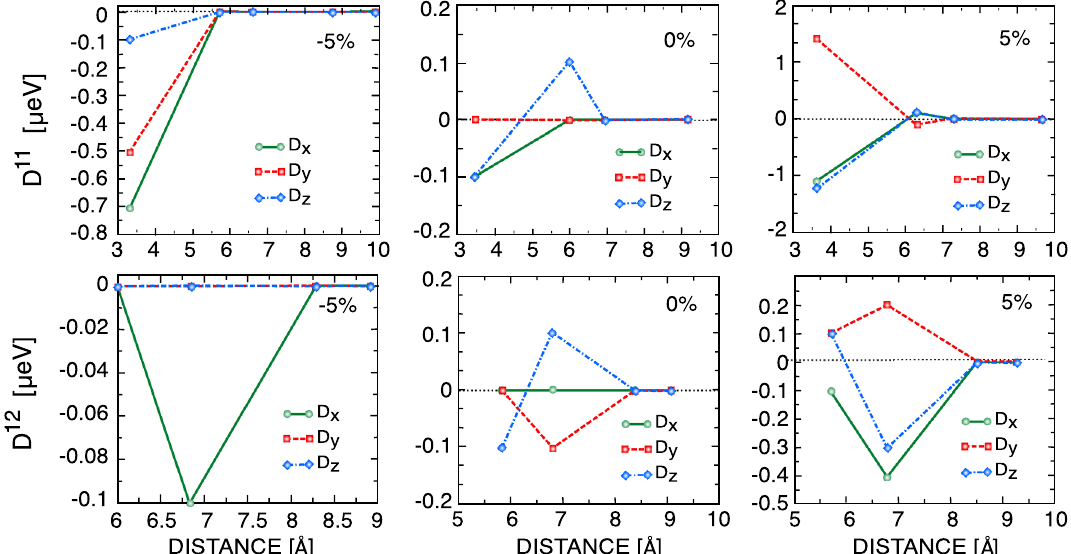
Figure 6. (Color online) Intralayer (top panel) and interlayer (bottom panel) DMIs of bilayer CrCl 3 for unstrained (middle), − 5% strained (left) and +5 % strained (right)